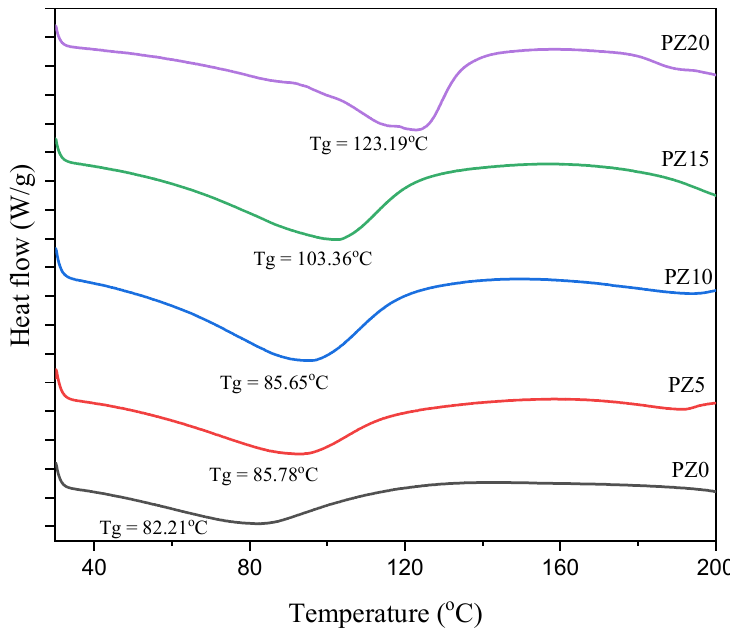
Figure 6. DSC scans for the developed composite polymer electrolyte. Table 2. Summary of T g and FWHM of polymer blend